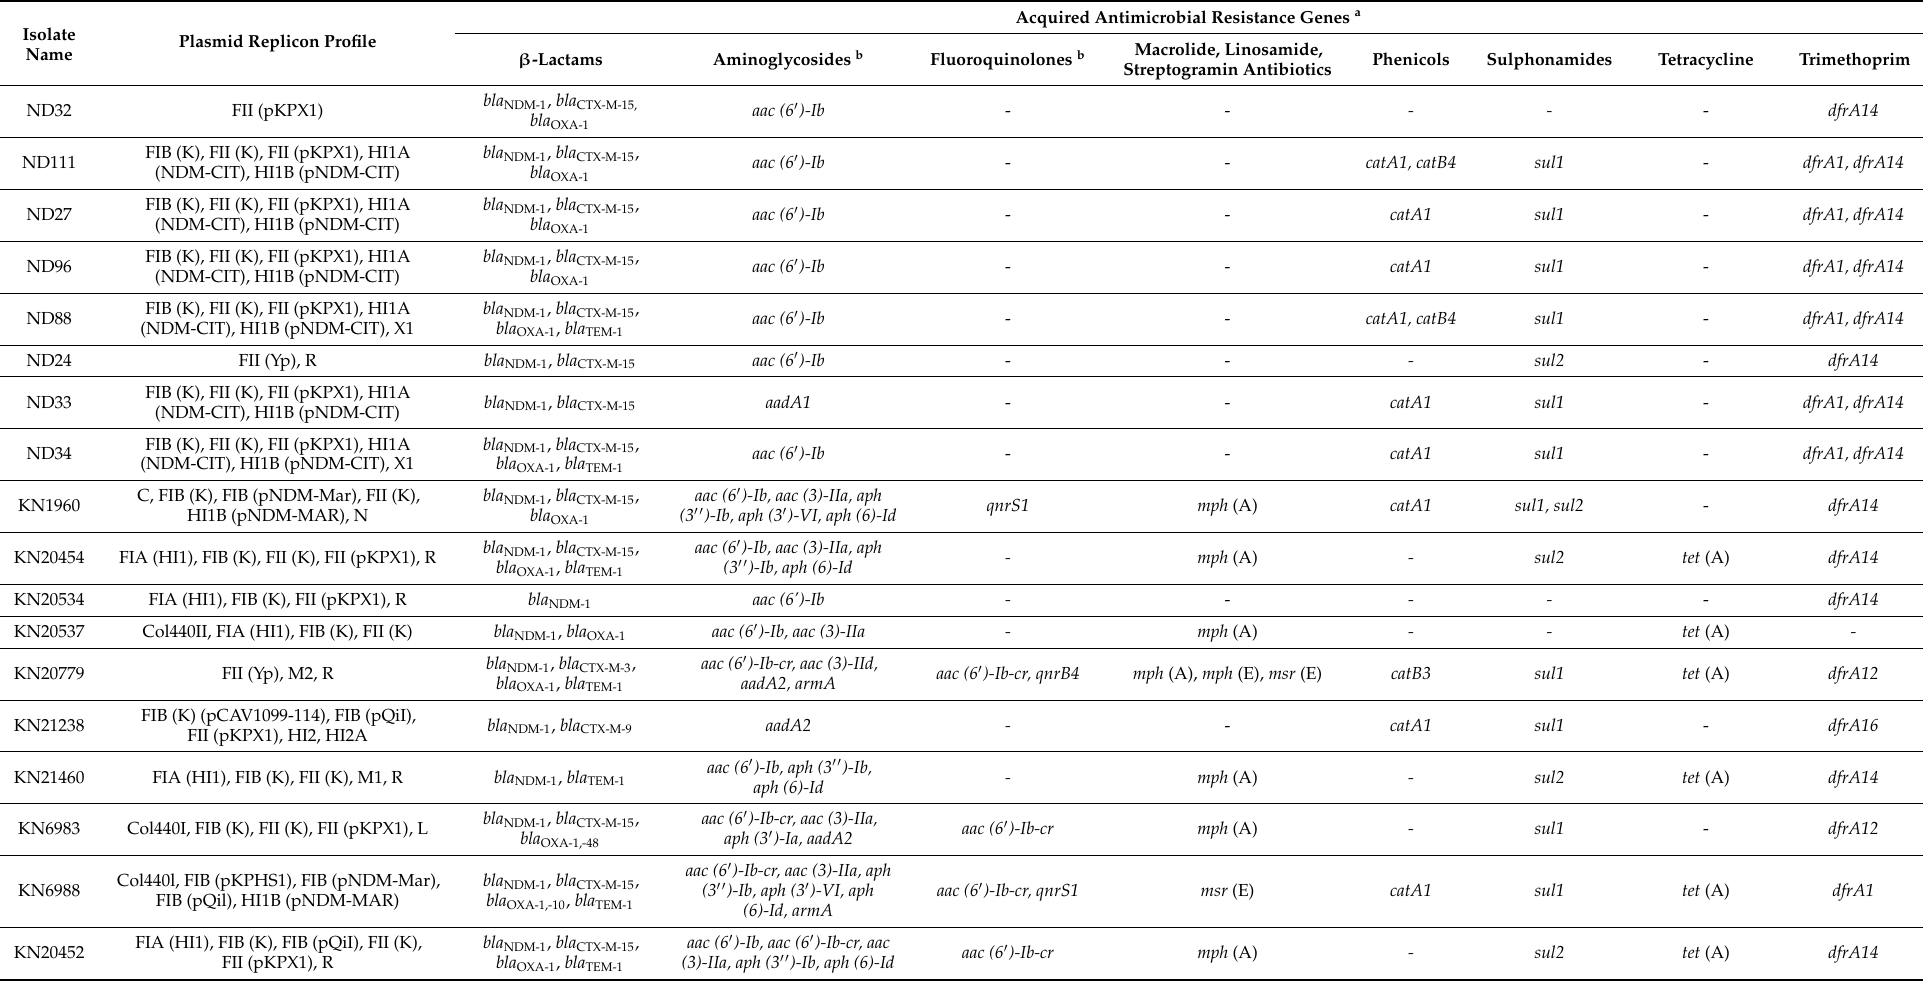
Table 3. K. pneumoniae NDM-1 ST11 isolates included in this study and from the PATRIC database—plasmid replicon profile and resistomes based on sequencing